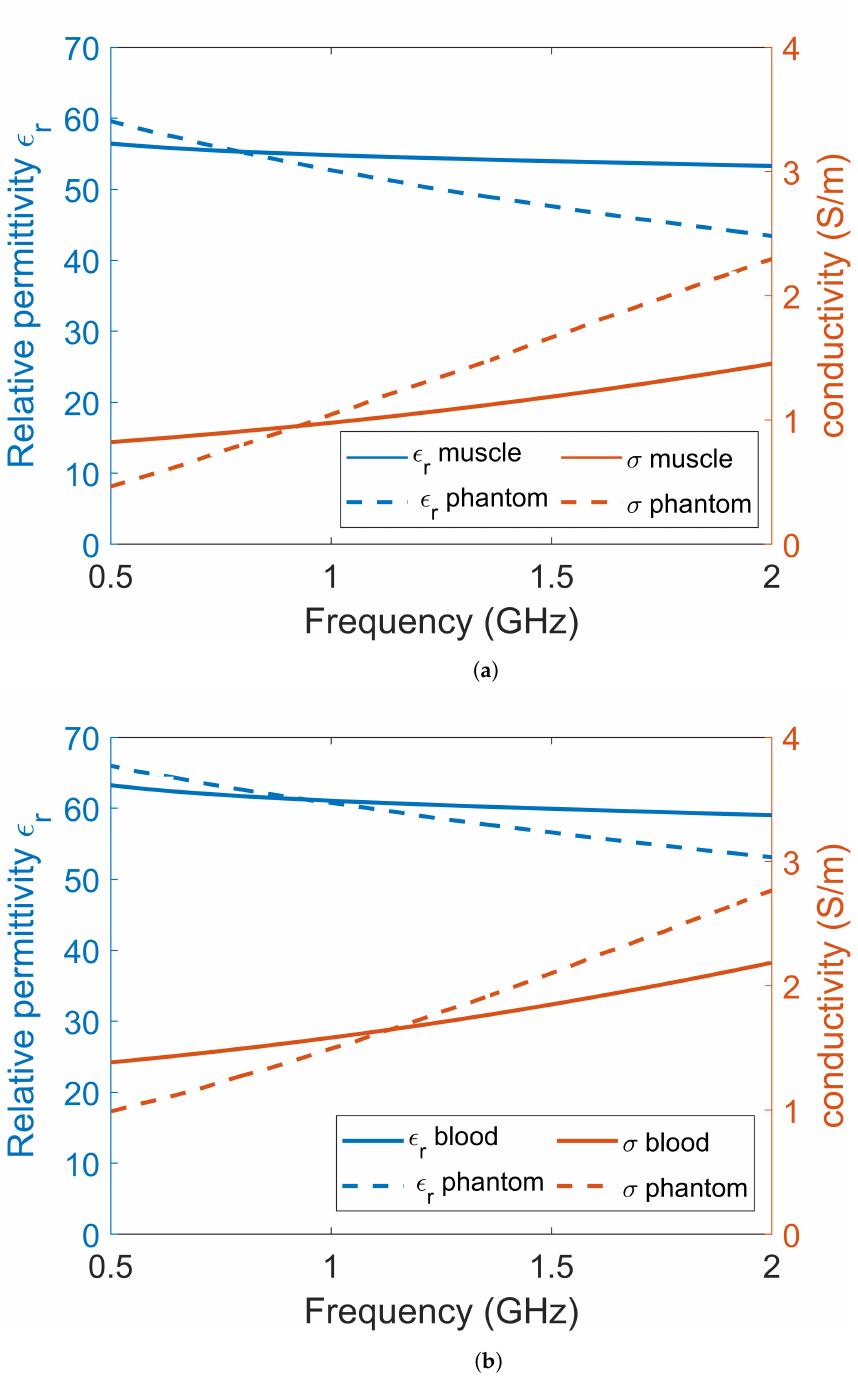
Figure 1. The dielectric data for ( a ) muscle tissue and ( b ) blood tissue. Each plot contains the permittivity and conductivity data from the literature, the measured dielectric values of the phantoms and the corresponding data that were used in the